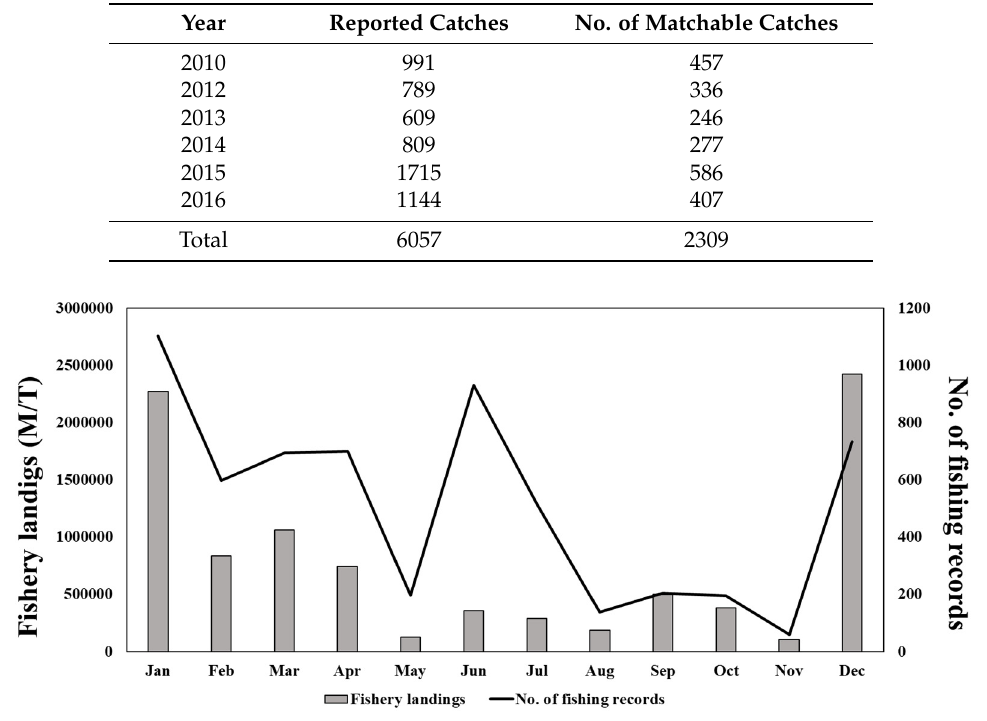
Figure 3. Monthly distribution of total fishery landings (M/T) and the number of fishing records.